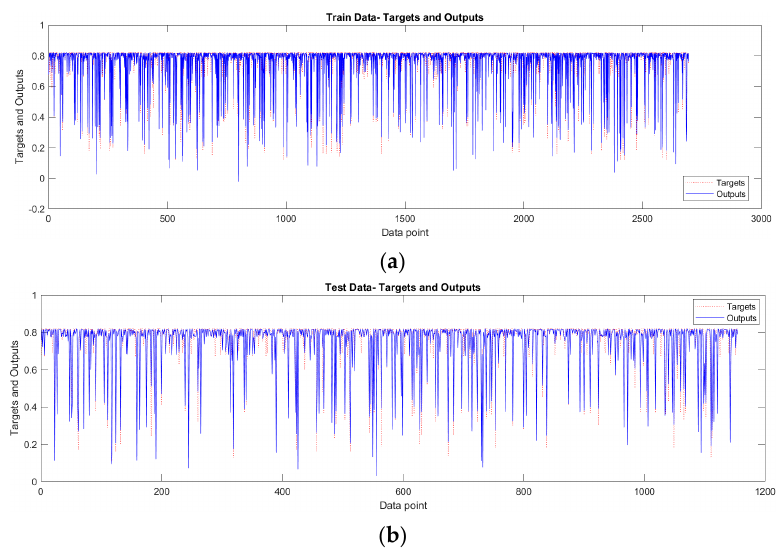
Figure 6. Comparison between real values (targets) and predicted values (outputs) for ( a ) training dataset, and ( b ) testing dataset.